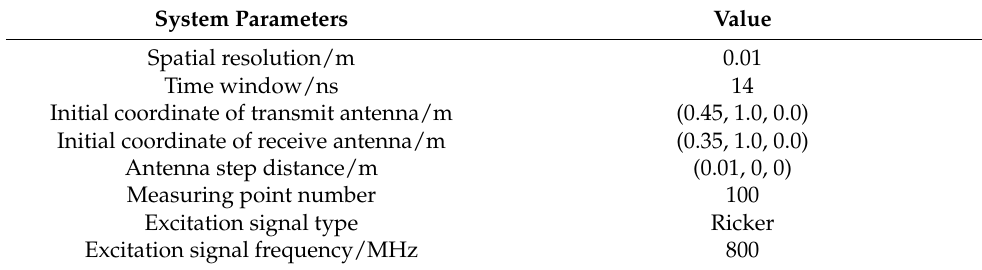
Figure 10. GprMax3D simulation flowchart. Table 1. GPR system parameters in road structure